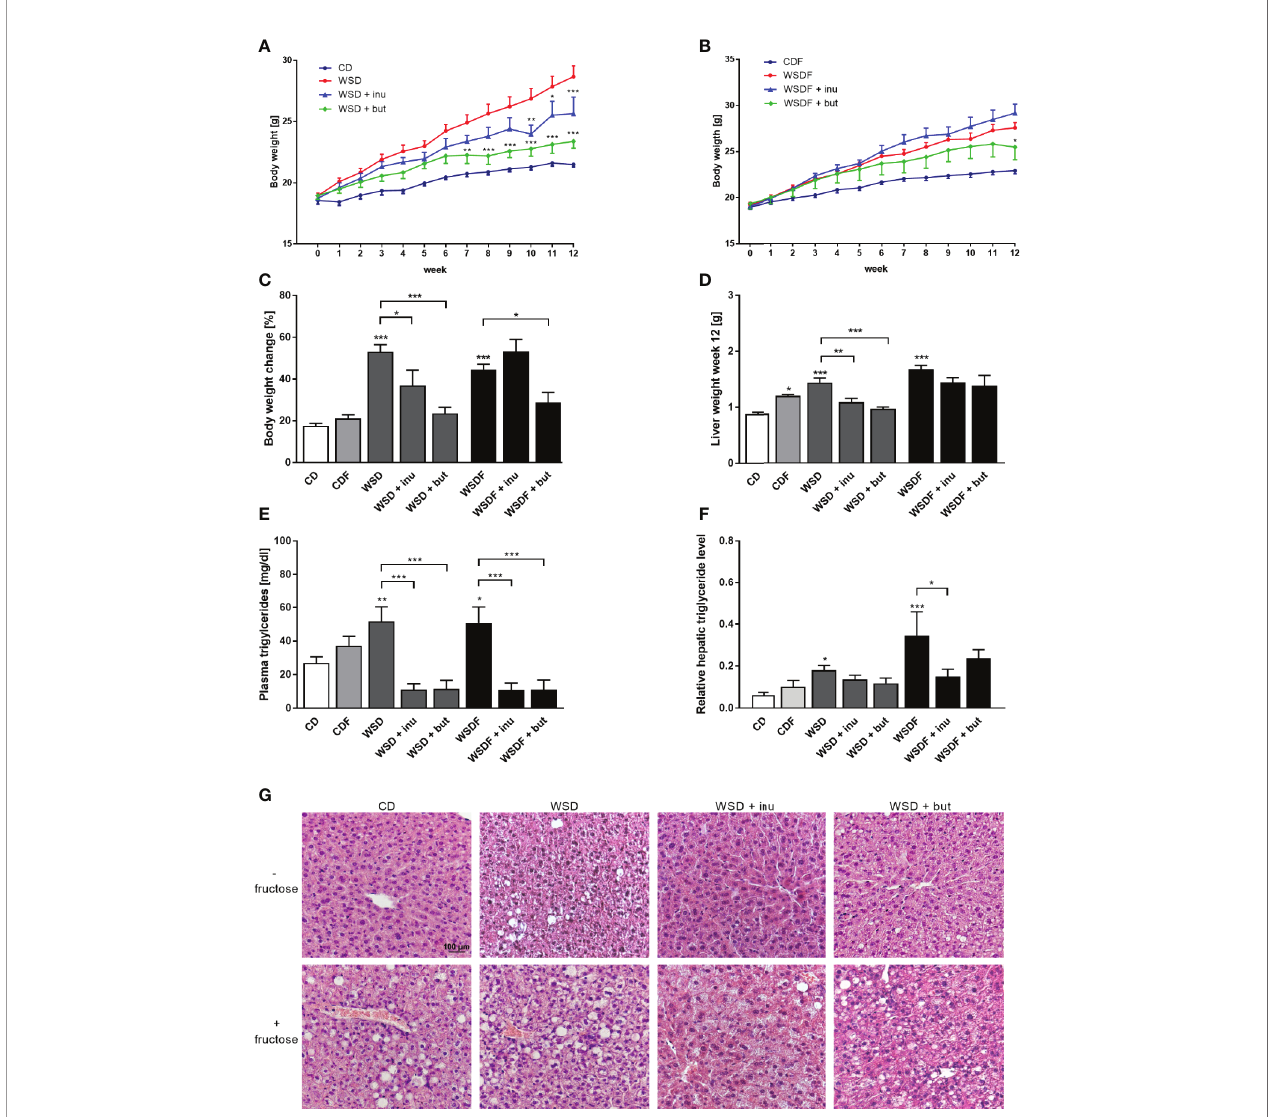
FIGURE 1 | Inulin and sodium butyrate reduce body weight and liver weight gain and attenuate hepatic steatosis in WDF-fed mice. C57BL/6 mice fed either a control diet (CD), a Western-style diet (WSD) or a WSD supplemented with 10% inulin (inu) or 5% sodium butyrate (but) with or without additional fructose (F) are shown. Weight development of mice fed diets without fructose (A) and with fructose (B) during the intervention of 12 weeks. Body weight change (C) , liver weight (D) , triglyceride concentration in plasma (E) and hepatic triglyceride level relative to protein concentration in liver tissue (F) after the 12-week intervention period. (G) Representative images of liver specimens stained with hematoxylin and eosin. Scale bar: 100 µm. Data are presented as means +/- standard error of the mean (SEM) (n = 6 – 8). Statistical analysis was performed by 2-way ANOVA with Tukey ’ s multiple comparisons test (A, B) or one-way ANOVA with Sidak´s post-test. Signi fi cant differences are indicated as *p-value < 0.05; **p-value < 0.01; ***p-value <